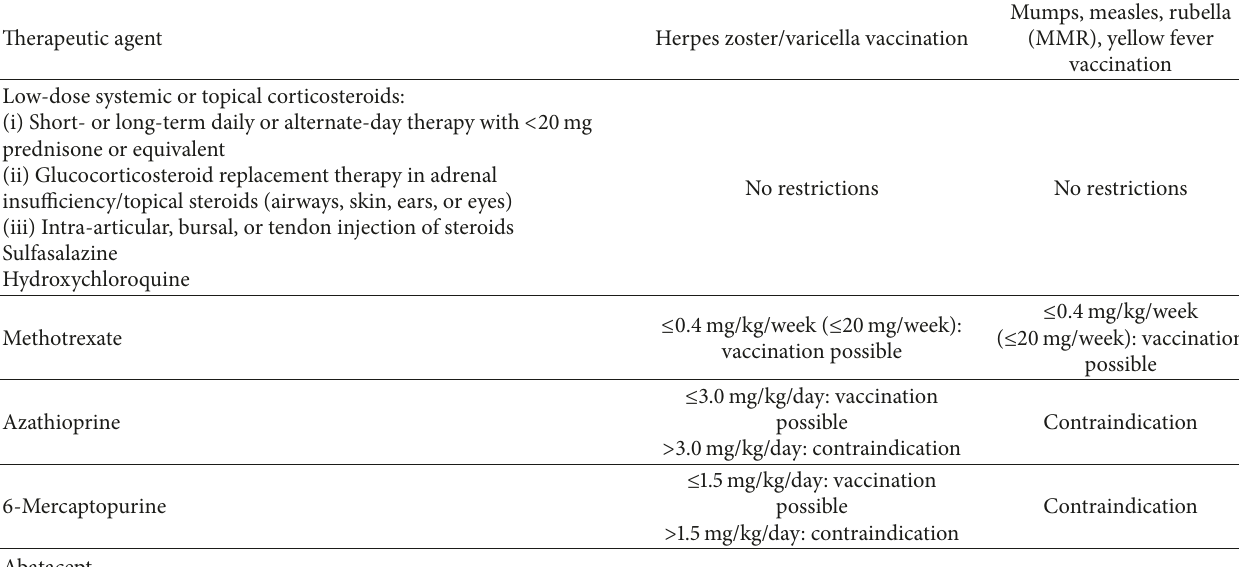
Table 3: Live vaccines during immunosuppressive therapy [40].